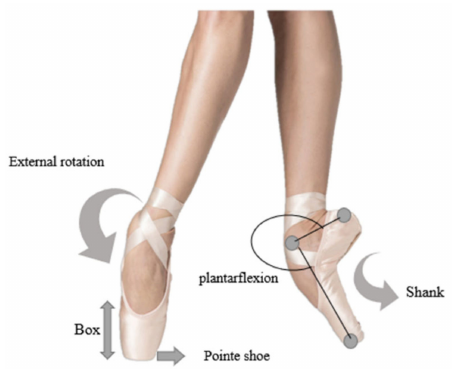
Figure 1. Dancing in the en pointe phase (pointe shoes: the shoes worn by ballet dancers during performance or training; Box: a shoe box that wraps and supports the toes at the front of the shoe; Shank: a piece of rigid shoe bone that reinforces the sole for more